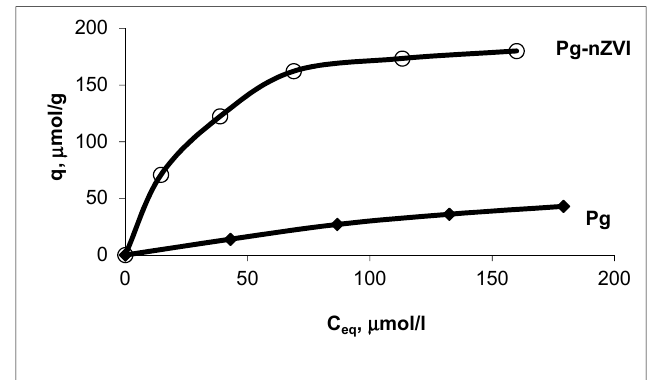
Figure 7. Sorption isotherms of U(VI) ions on pristine paligorskite and paligorskite-nZVI.